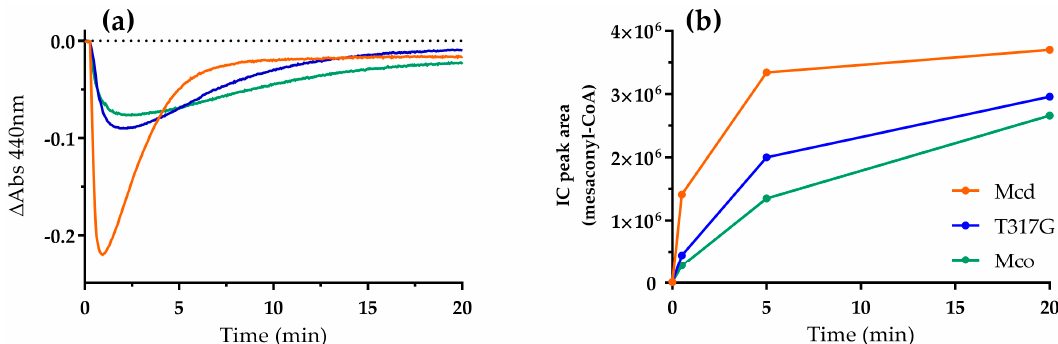
Figure 5. Reaction of Mcd (orange), T317G (blue) and Mco (green; 0.1 µM each) with ETF as electron acceptor (55 µM) under oxic conditions. Reactions were started by the addition of (2 S )-methylsuccinyl-CoA (100 µM). ( a ) The redox state of the ETF-bound FAD was observed at 440 nm; and ( b ) samples were directly taken from the cuvette and analyzed for product (mesaconyl-CoA) by LC-MS.